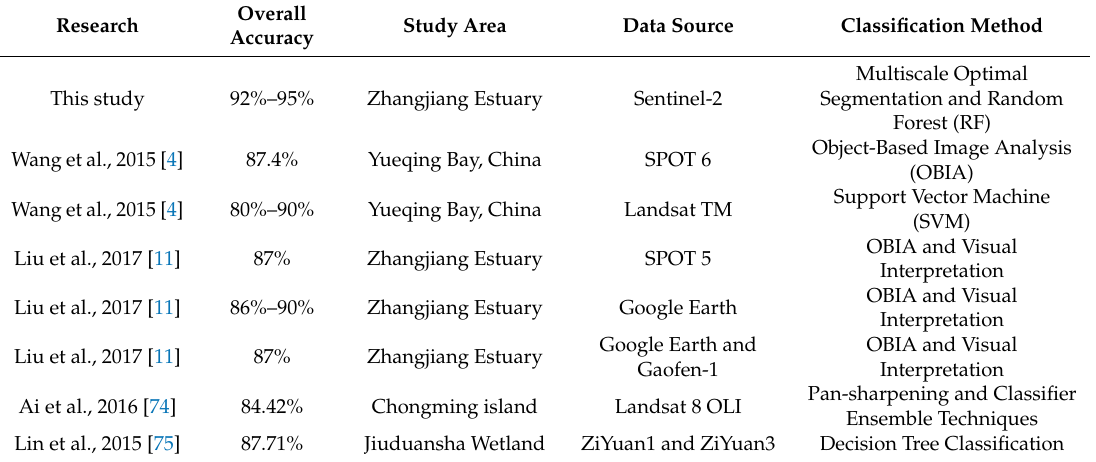
Table 6. Overall accuracy of S. alterniflora obtained from di ff erent sensors and classification